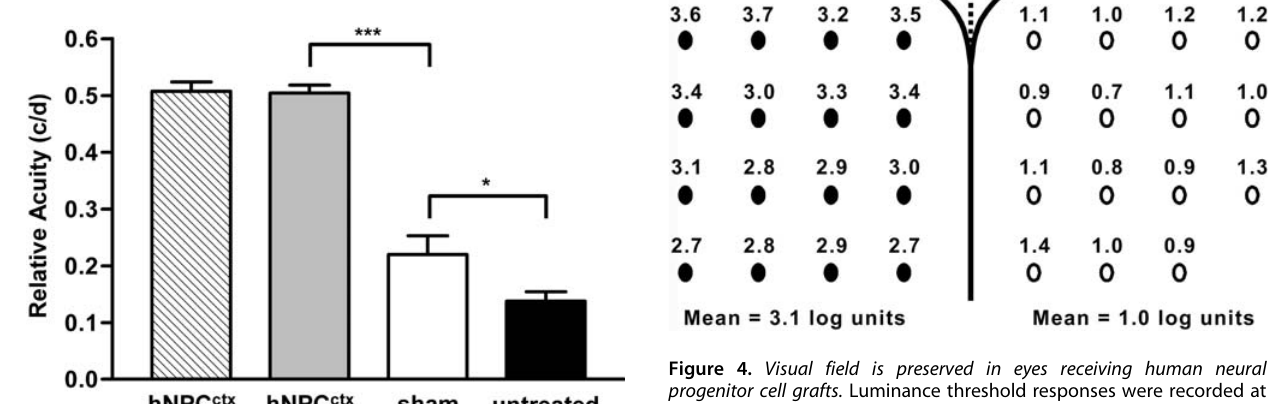
Figure 4. Visual field is preserved in eyes receiving human neural progenitor cell grafts. Luminance threshold responses were recorded at approximately P100 from multiple points within the superior colliculus (SC) contralateral to the eye being tested. This method quantifies functional sensitivity to light across the visual field of an eye. The topographical map depicts the luminance threshold responses (measured in log units relative to background illumination of 0.02 cd/ m 2 ) at 15 points within the SC opposite the cell-injected eye of a best- performing animal at P104 ( right side of figure). SC recordings (16 points) opposite the fellow, untreated eye ( left side of figure) served as an internal control. Both hNPC ctx –GDNF and hNPC ctx transplant recipients were included in the cell-injected group, which consisted of a select population of eyes that displayed superior performance on spatial visual acuity testing. Recordings falling at or below a threshold of 2.0 log units are indicated with unfilled ovals , while recordings above 2.0 are demarcated with filled ovals .